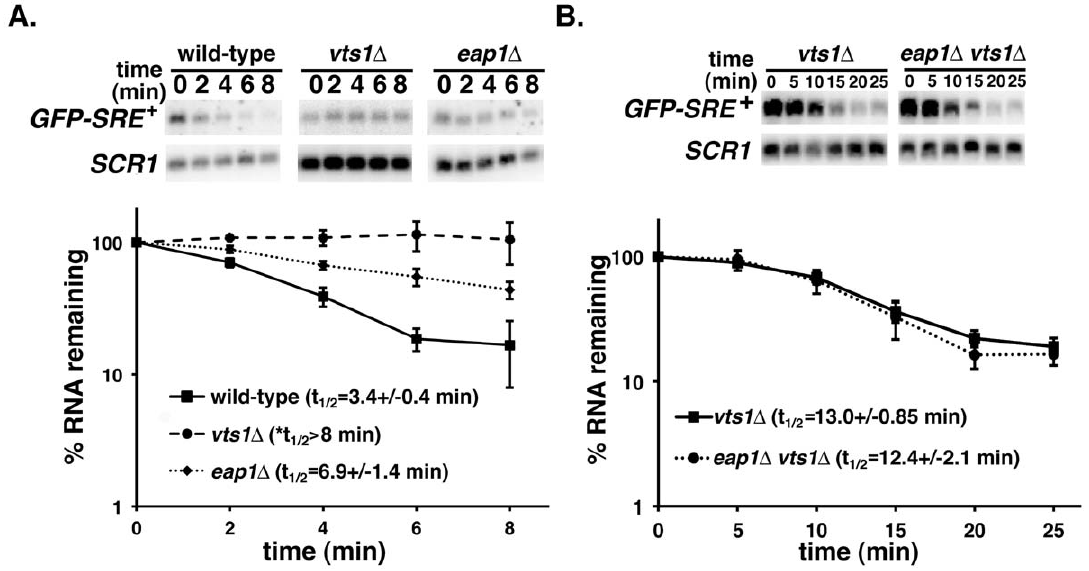
Figure 1. Eap1p and Vts1p function in the same pathway to destabilize GFP-SRE + mRNA. GFP-SRE + mRNA expression was induced in the indicated strains and then shut-off with glucose and reporter mRNA levels were assayed at the times indicated after transcriptional shutoff by Northern blot. The results of at least three independent experiments were quantitated and normalized using the levels of SCR1 RNA and graphed with error bars representing standard deviation. *Note that an accurate measure of the half-life of GFP-SRE + mRNA can be found in Figure